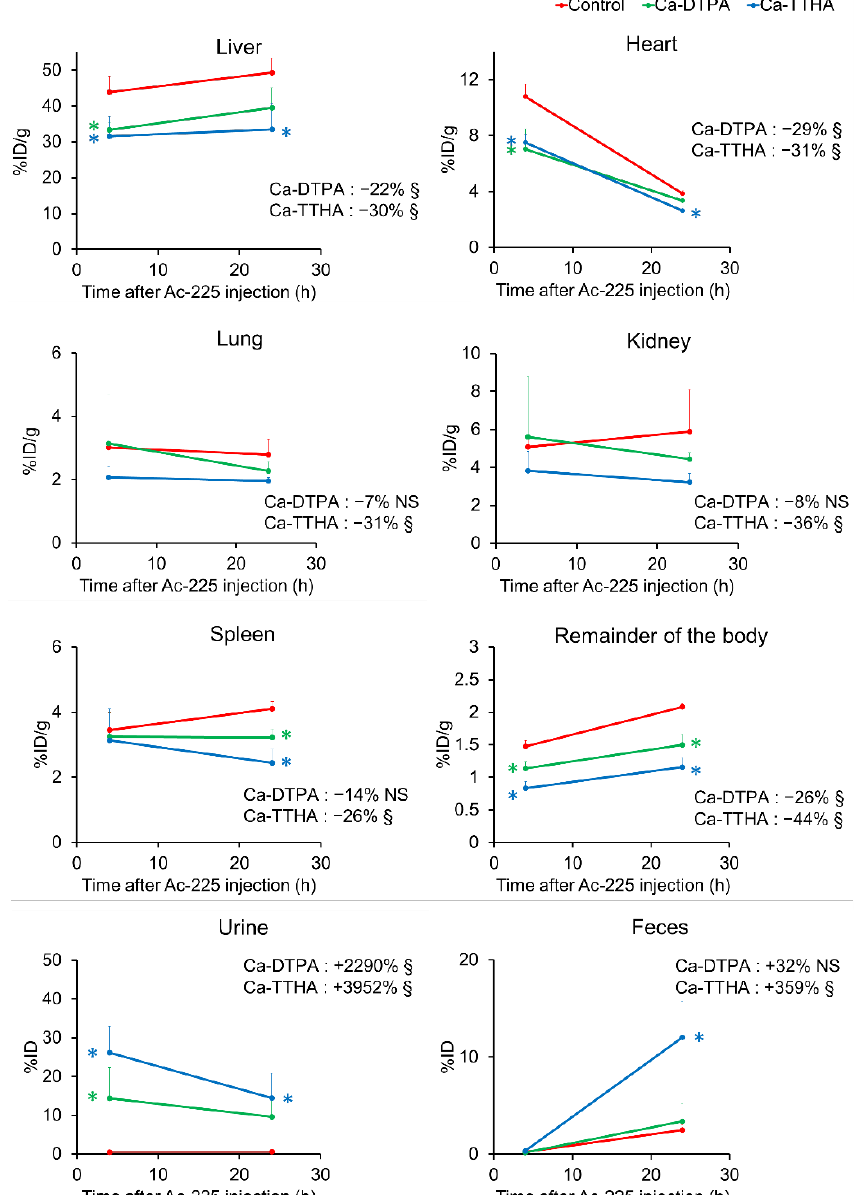
Figure 6. Time–activity curves of free actinium-225 ( 225 Ac) after Ca-DTPA and Ca-TTHA administration in major organs, urine, and feces. Time–activity curves were generated using the biodistribution of 225 Ac in control mice and mice with Ca-DTPA and Ca-TTHA at 4 and 24 h after 225 Ac injection. Values are shown as mean ± SD; n = 4–5. Numbers in the graphs show the % increase (positive) or decrease (negative) of the area-under-the-curve in each chelator group, compared to the control. § indicates the statistical significance of time–activity curves ( p < 0.05, vs. control). NS = not significant. * indicates statistical significance at each time point ( p < 0.05, vs. control). The data for the other organs are shown in Figure